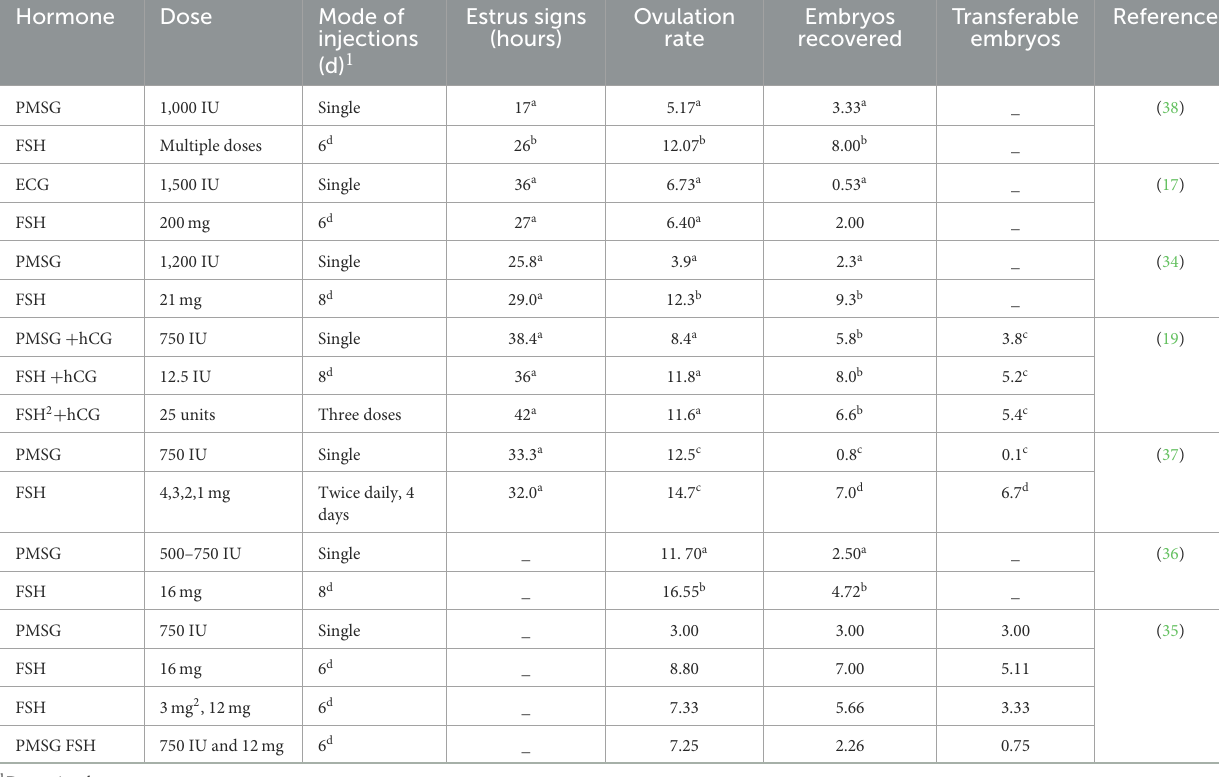
TABLE 1 Comparison of FSH and PMSG for the induction of the superovulatory response. Hormone Dose Mode of